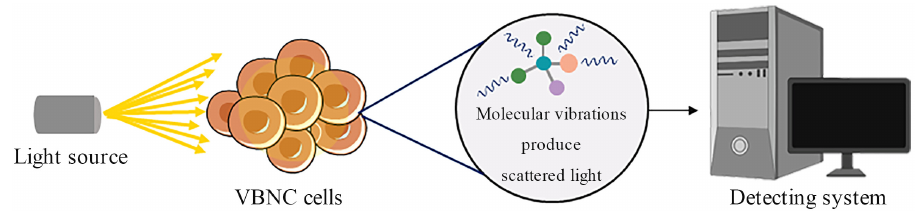
Figure 6. Schematic diagram of Raman spectroscopy.